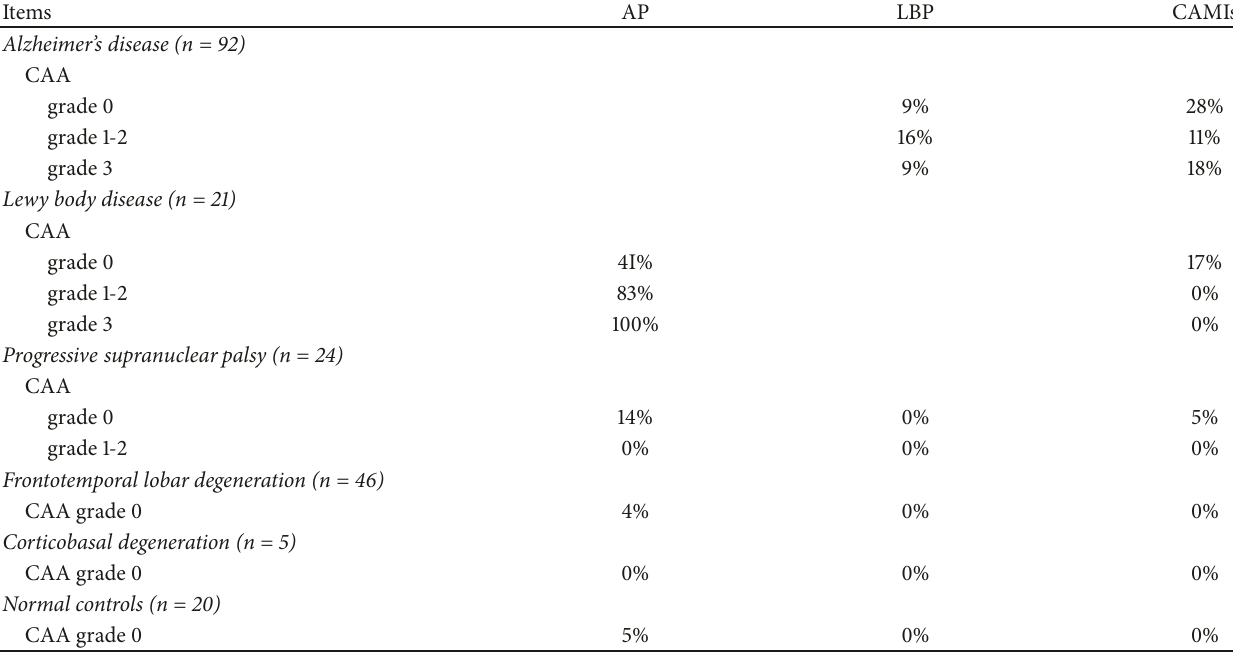
Table 2: Frequency of additional Alzheimer’s pathology (AP), Lewy body pathology (LBP), progressive supranuclear palsy pathology (PSP), andcerebralarterioscleroticmicro-infarcts(CAMIs)indifferentneurodegenerativedementiadiseasesaccordingtothegradingoftheseverity amyloid angiopathy